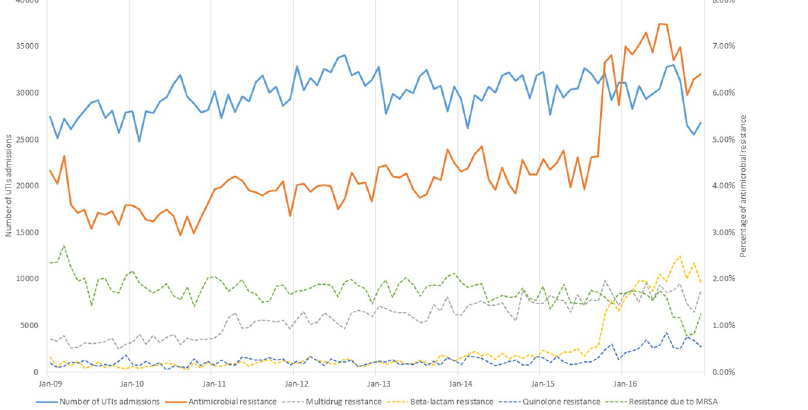
Fig 1. Trends in primary UTIs admission and antimicrobial resistance from 2009–2016.